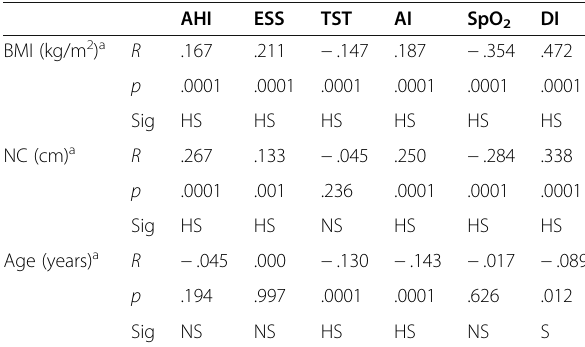
Table 5 Correlation between each of age, BMI, and the NC with ESS, AHI, and sleep data